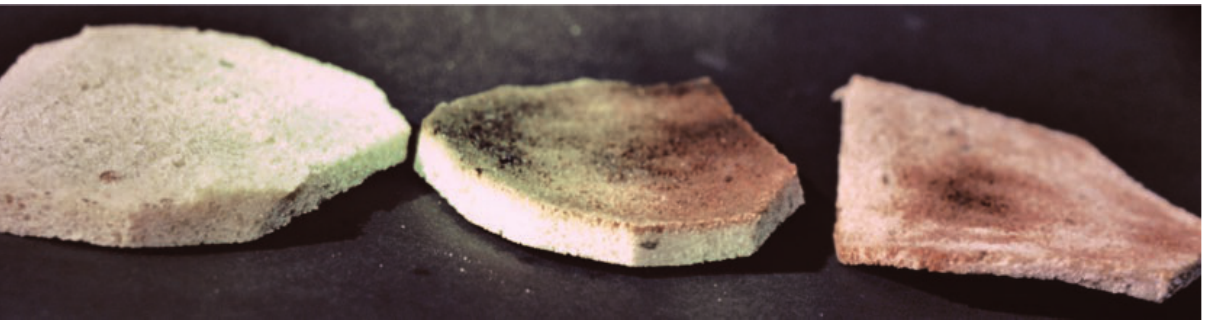
Figure 27. Th e shape of a bread-slice can be changed by selective grilling. If the fl at slice (left ) is grilled on one side only, it becomes elliptic (middle); further grilling of the other side as well gives a hyperbolic slice